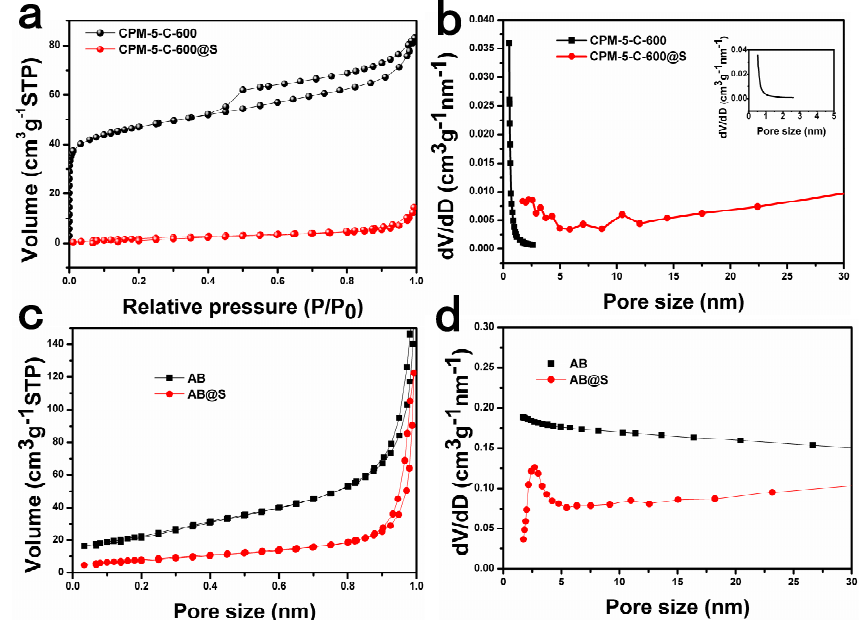
Figure 4. ( a ) Nitrogen adsorption-desorption isotherms and ( b ) pore size distribution curves of CPM-5-C-600 and CPM-5-C-600@S composites. ( c ) Nitrogen adsorption-desorption isotherms, and ( d ) pore size distribution curves of AB and AB@S composites.